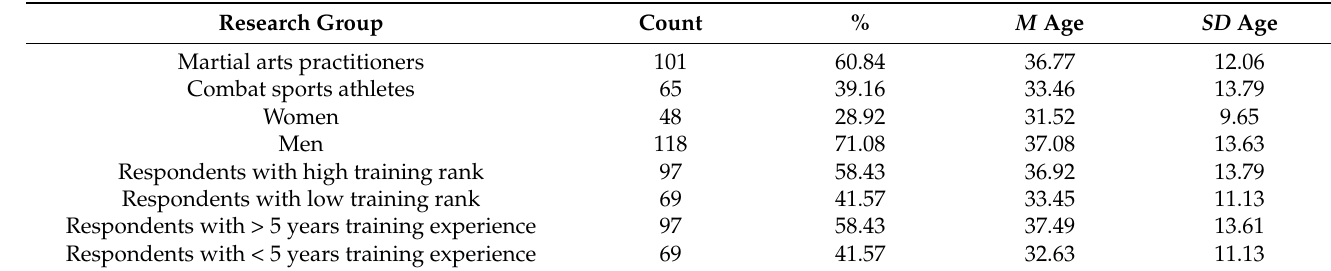
Table 1. Demographic characteristics of the